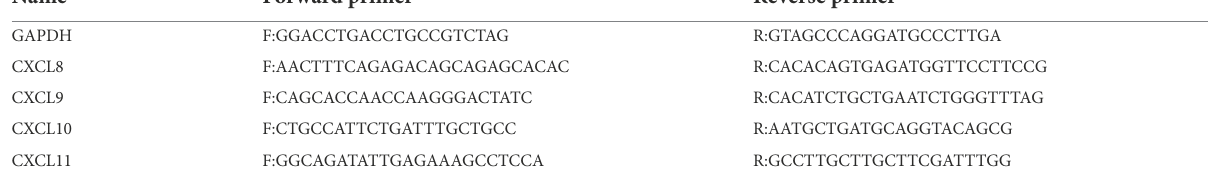
TABLE 1 qPCR primer